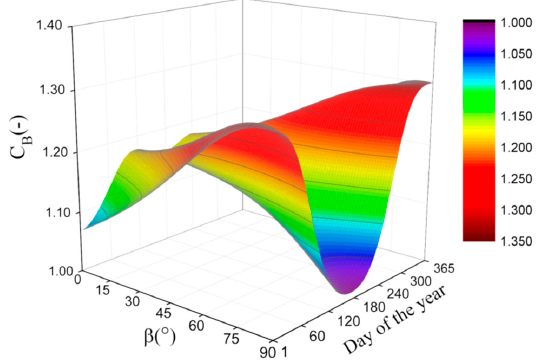
Figure 24. Surface chart of C B varying with β and day of the year at 30 ◦ N and ρ = 0.2.